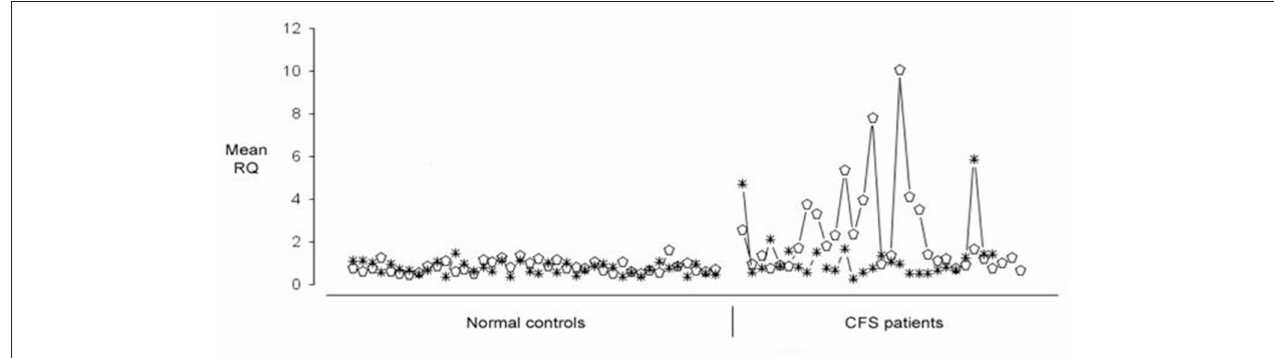
FIGURE 1 | Expression of Epstein-Barr Virus (EBV) induced gene 2 ( EBI2 ) (open ellipse) and Neuropathy Target Esterase (NTE) (asterisk) genes in 40 healthy blood donors (shown on the Left ) and 31 Chronic Fatigue Syndrome/Myalgic Encephalomyelitis (CFS/ME) patients (shown on the Right ). Upregulated EBI2 mRNA expression was demonstrated in 12 of 31 CFS/ME patients, and in none of the controls.